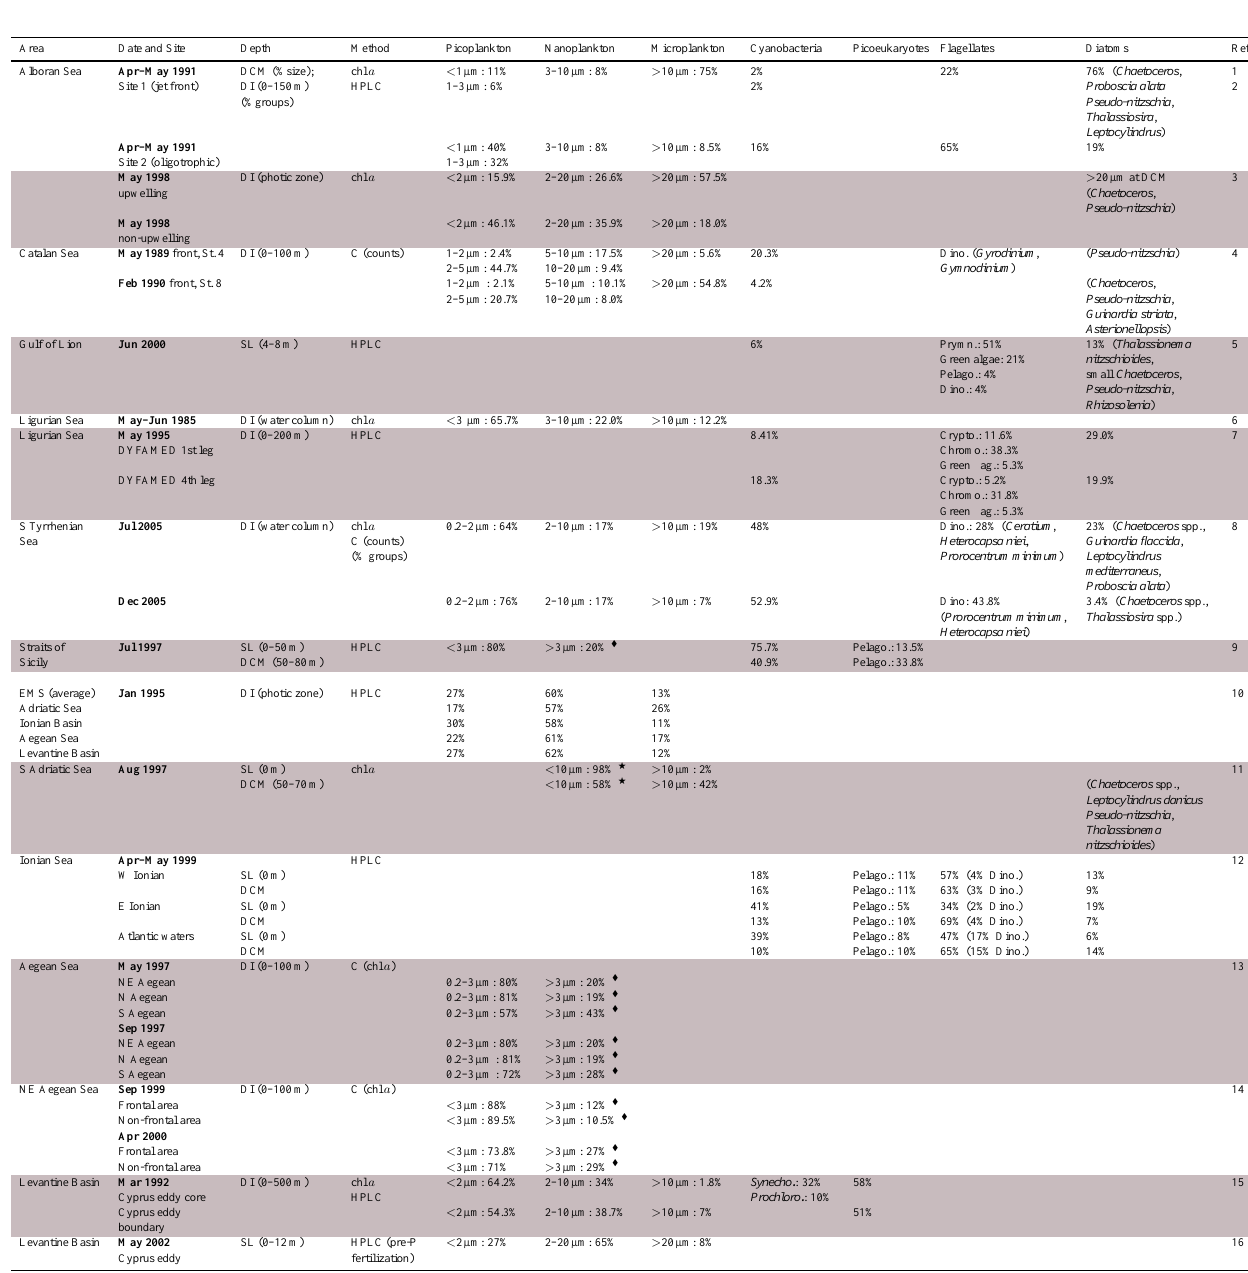
Table 1. Selected examples of phytoplankton size fractions and/or taxonomic composition in different areas of the MS: WMS. Values have been rounded to the first decimal digit. Abbreviations: SL for Surface Layer, DCM for Deep Chlorophyll Maximum, DI for Depth Integrated, C for Carbon, HPLC for pigment-based group discrimination, Dino. for dinoflagellates, Prymn. for prymnesiophytes, Pelago. for pelagophytes, Crypto for cryptophytes, Chromo. for nanoflagellates containing 19 ′ –HF and/or 19 ′ –BF, Nano. for nanoplankton, Cocco. for coccolithophores, Synecho. for Synechococcus , Prochloro. for Prochlorococcus . The values reported in Refs. 1, 3, 7 and 9 are derived from figures in the respective papers.